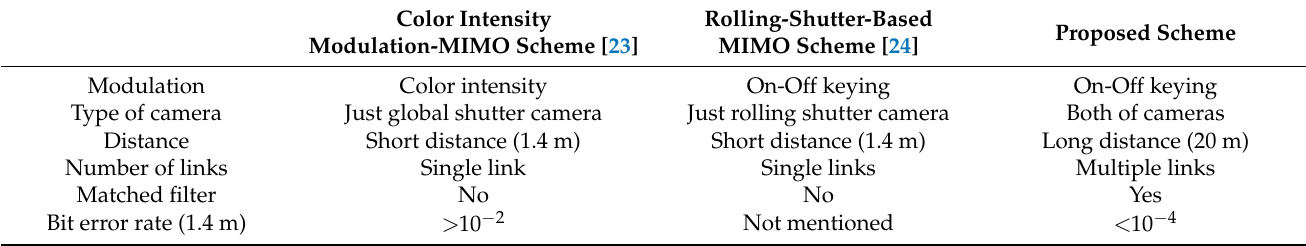
Figure 17. BER performance of the proposed scheme for an 8 × 8 LED matrix with different exposure times. Table 2. Summary of comparison of MIMO-OCC methods.